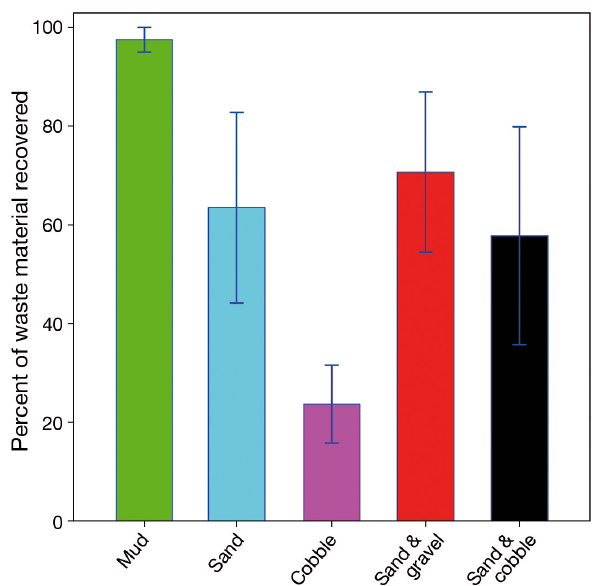
Fig. 2. Percent of salmon aquaculture waste material (mean ± SD) recovered from the erosion experiments (n = 6) com- pleted on each bottom substrate (mud, sand, cobble, sand and gravel, sand and